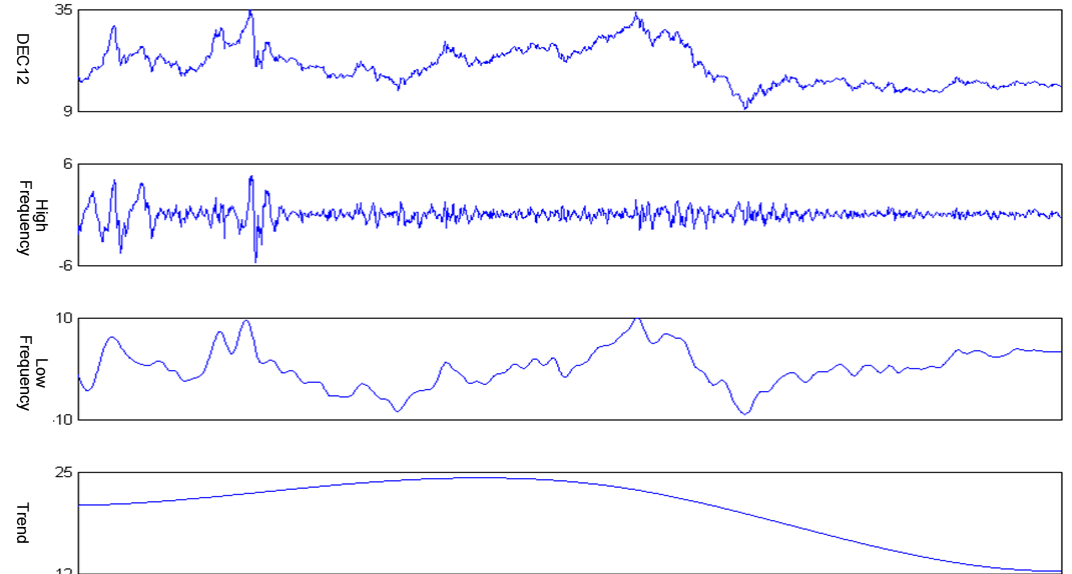
Table 1. Mean of